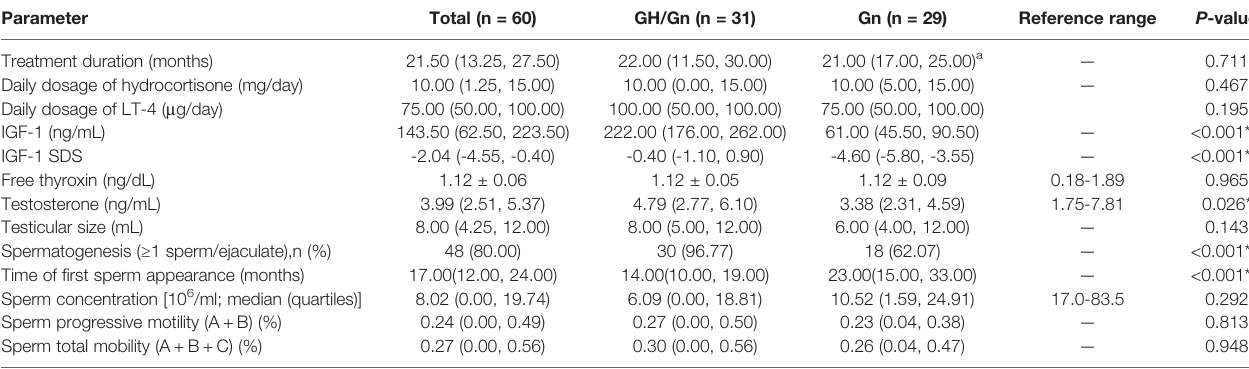
TABLE 2 | Hormone levels and semen quality after therapy.